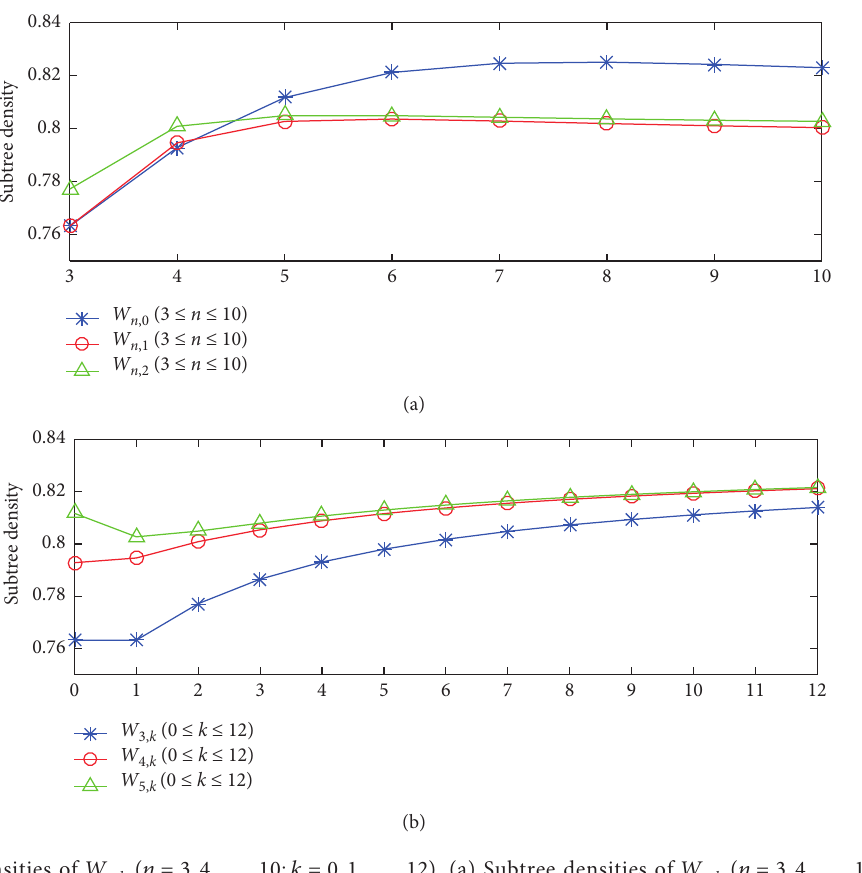
( n � 3 , 4 , . . . , 10 ; k � 0 , 1 , . . . , 12 ) . (a) Subtree densities of W n,k